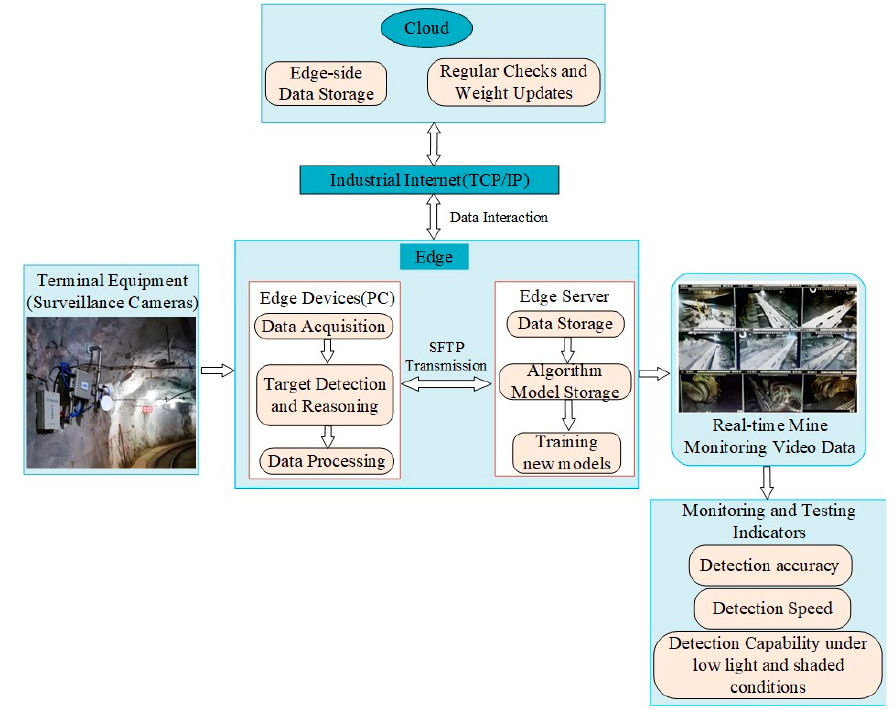
Figure 2. System architecture based on edge computing.